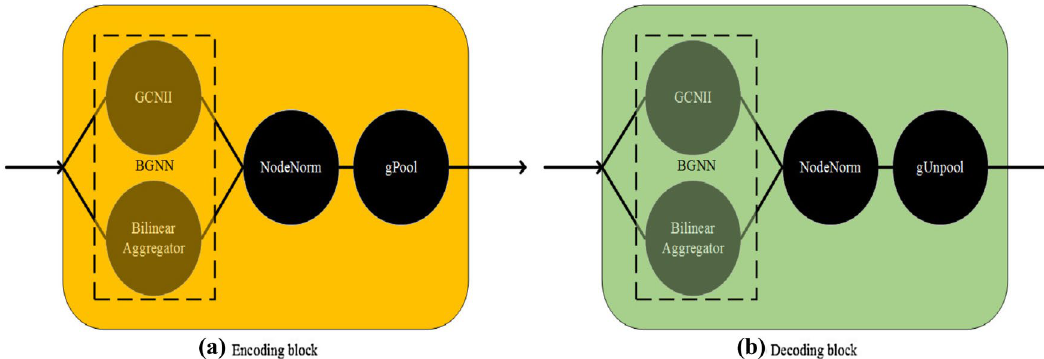
Fig. 5 The proposed encoding/decoding block of graph U-Net+